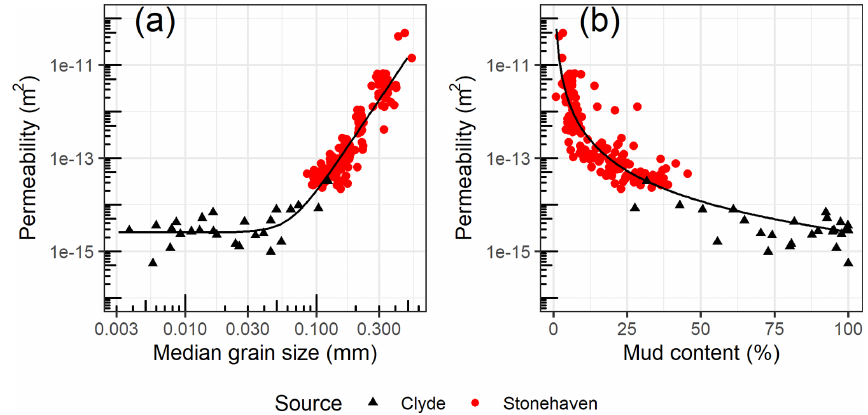
Figure 11. Relationship between sediment permeability (m 2 ) and (a) median grain size (mm) and (b) percentage of mud content for mea- surements from the Firth of Clyde (black triangles) and samples from the North Sea analysed by Serpetti et al. (2016) (red points). Fitted relationships for the combined data are shown by a solid line. Note log 10 scale.